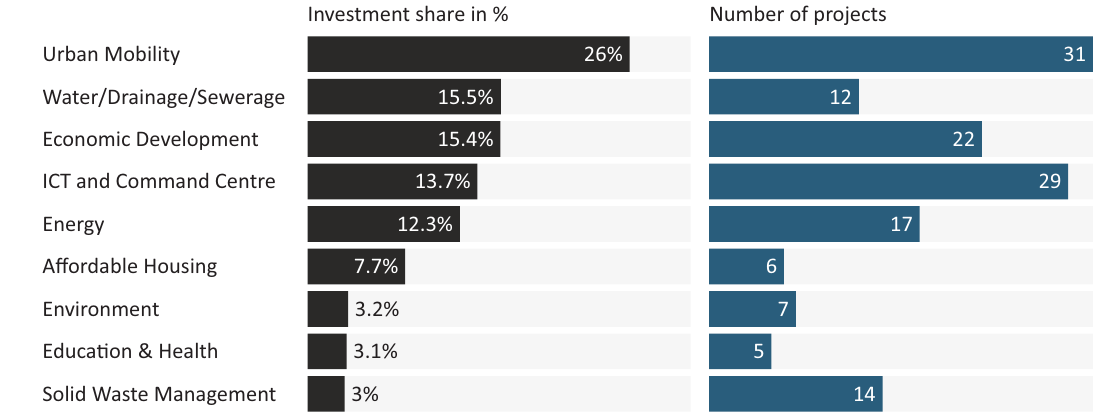
Figure 4. Sector wise investments and projects identified in the smart city proposals. Notes: Investment share was calcu‐ lated from smart city proposals from across 100 cities. The number of projects reflects data from the 33 cities selected in the first and second phase of the SCM in